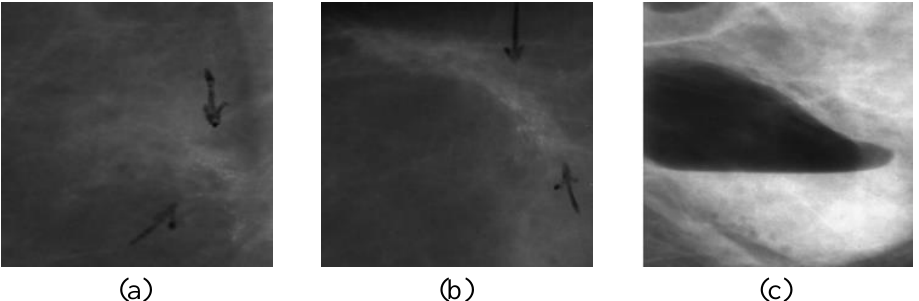
Figure 1. Examples of noisy and corrupted images. ( a , b ) contain some black arrow marks made by doctors or radiologists indicating the location of the lesion. ( c ) is a result of insufficient illumination or incorrect device adjustment.